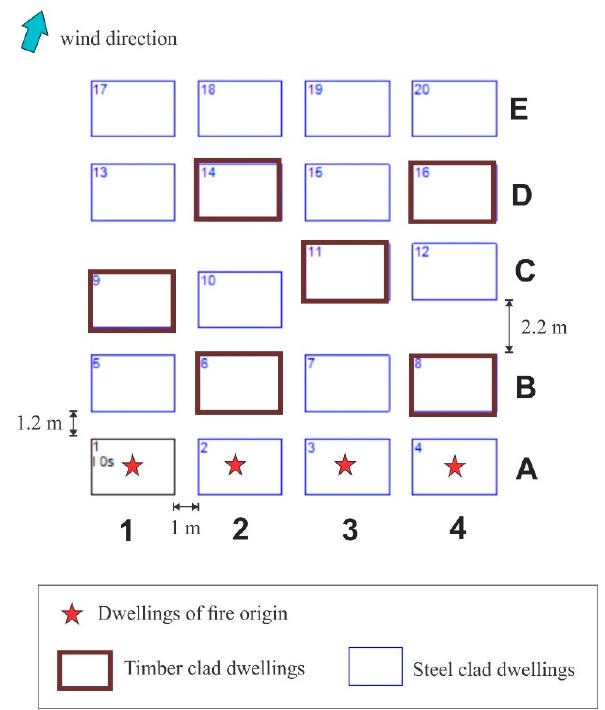
Figure 7. Layout of the 20-dwelling fire experiment [8].